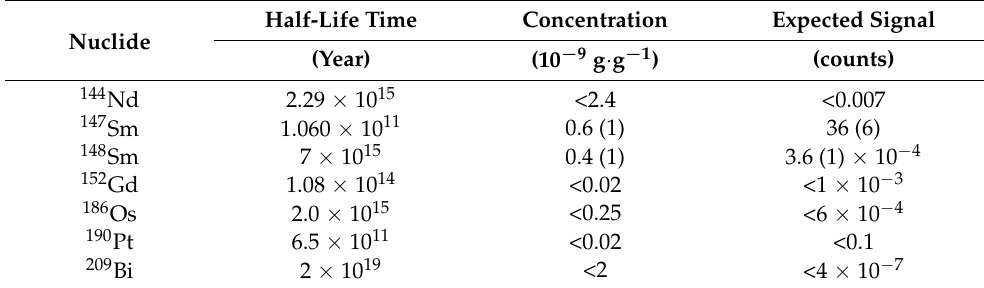
Table 4. Expected signals of interfering nuclides in the 174 Hf α decay energy region. Half-Life Time Concentration Expected Nuclide